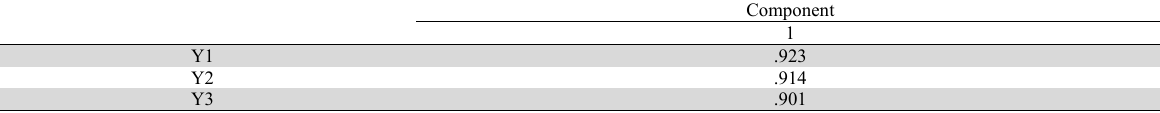
Exploratory Factor Analysis for dependent factor